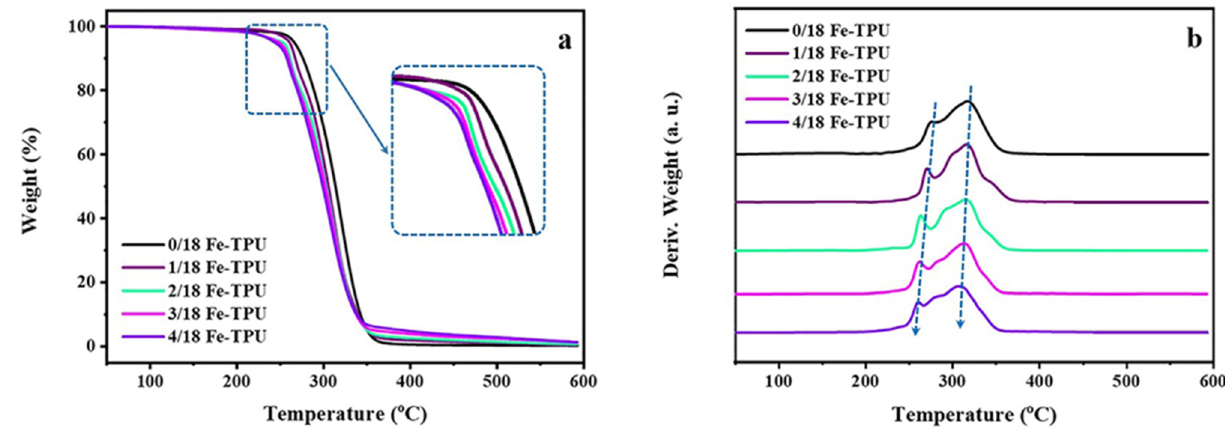
Figure 9. ( a ) TG curves, ( b ) DTG curves of TPU reinforced with FeCl 3 . Table 3. TGA data of TPU reinforced with FeCl 3 .